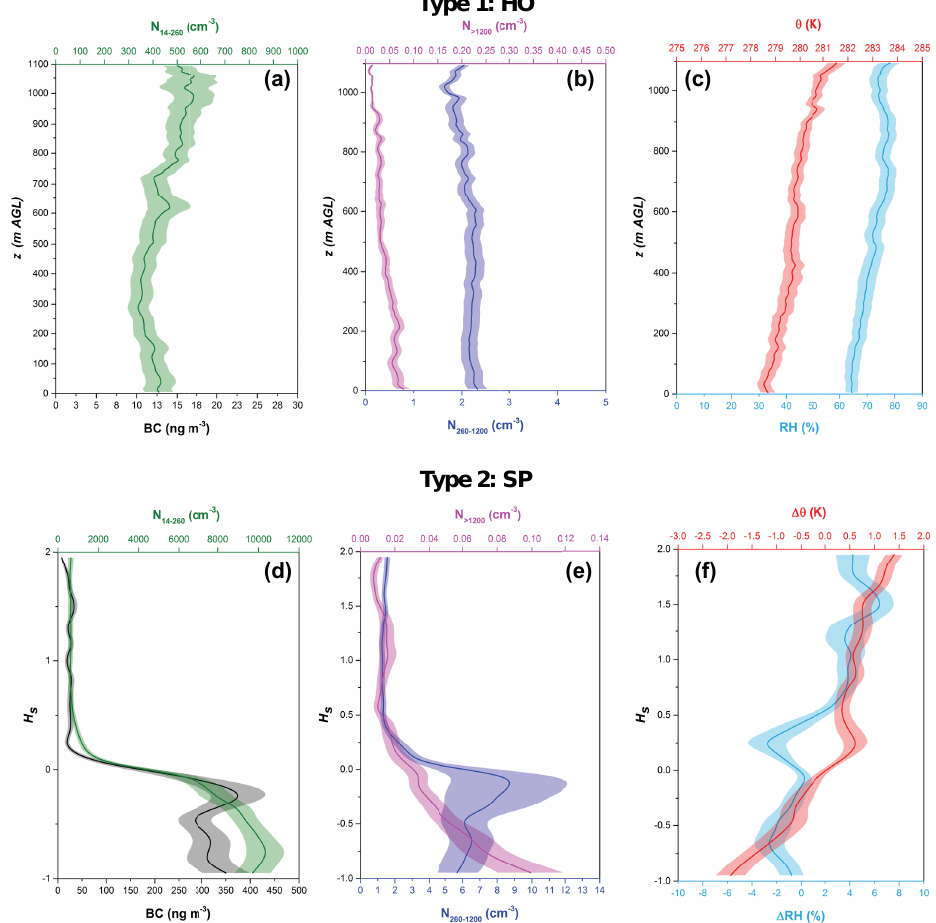
Figure 11. Summertime statistical mean profiles of N 14 − 260 (green line), BC (black line), N 260 − 1200 (blue line), N > 1200 (magenta line), θ (red line) and RH (light blue line) along height over Ny-Ålesund for the two typologies of vertical profiles: (a) – (c) homogeneous profiles (HO); (d) – (f) profiles impacted by shipping emissions